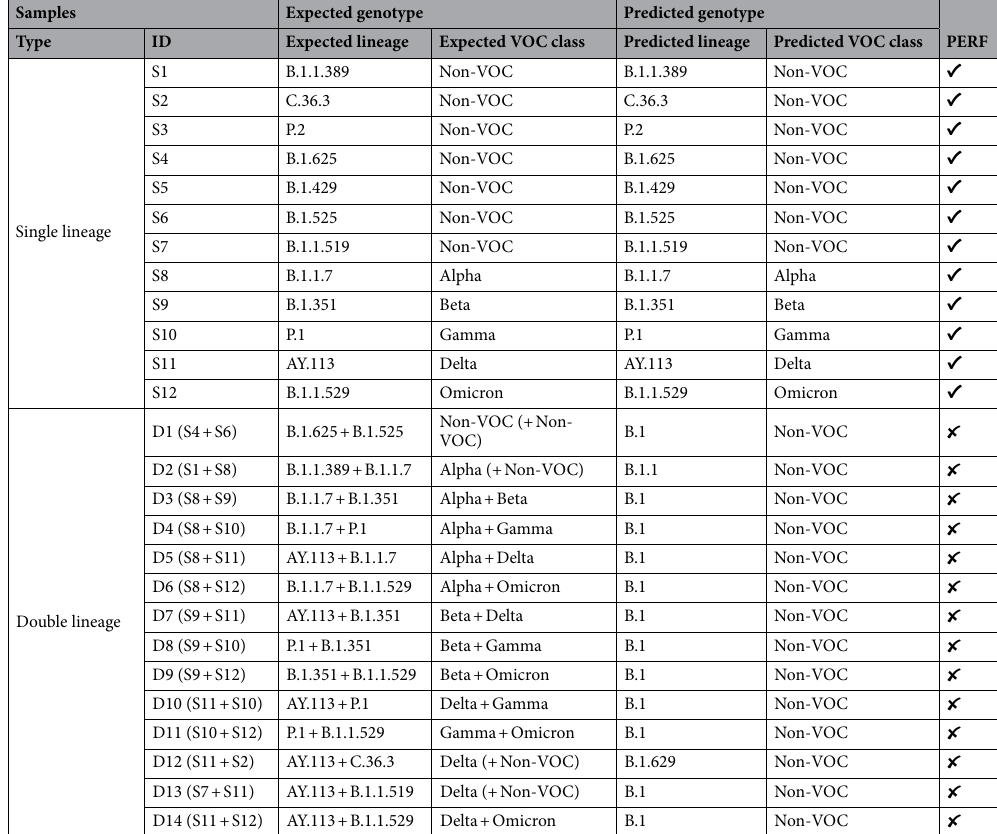
Table 2. Genome classification using a whole-genome assembly strategy with sequencing data for one or two variants of the SARS-CoV-2 virus (PERF: performance of the prediction regarding the expected class).